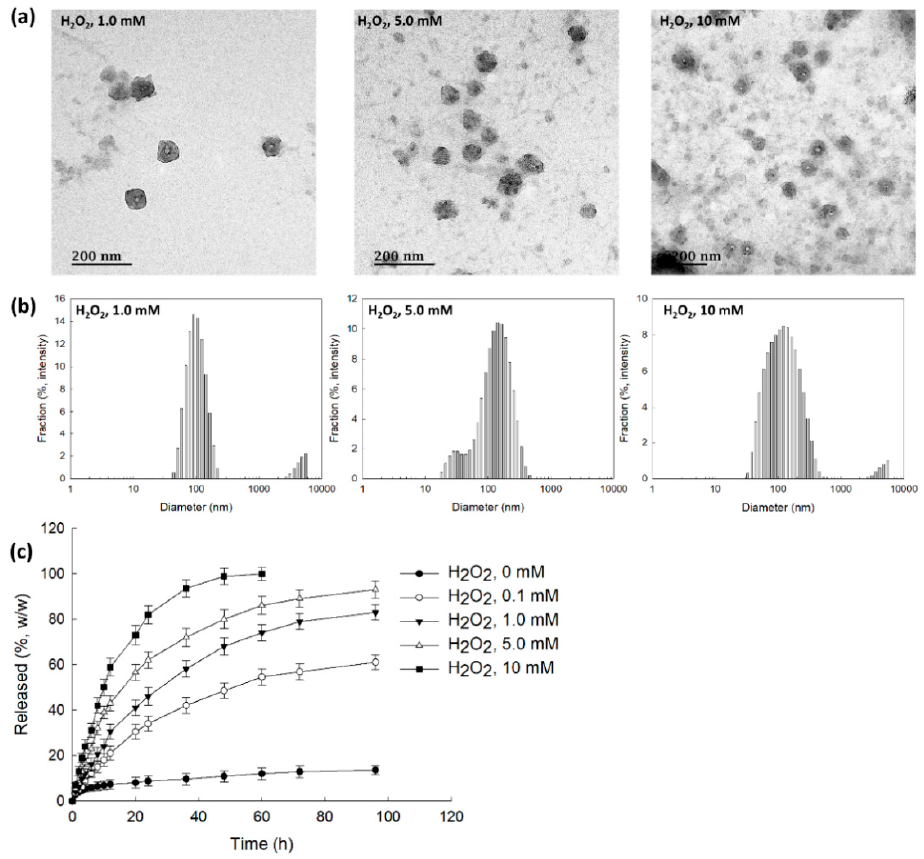
Figure 4. ( a ) The effect of H 2 O 2 on the morphological changes of bCDsuMema nanoparticles. ( b ) The effect of H 2 O 2 on the particle size distribution of bCDsuMema nanoparticles. ( c ) The effect of H 2 O 2 on the release of memantine from nanoparticles. The memantine concentration was adjusted to 0.1 mg/mL in PBS with or without H 2 O 2